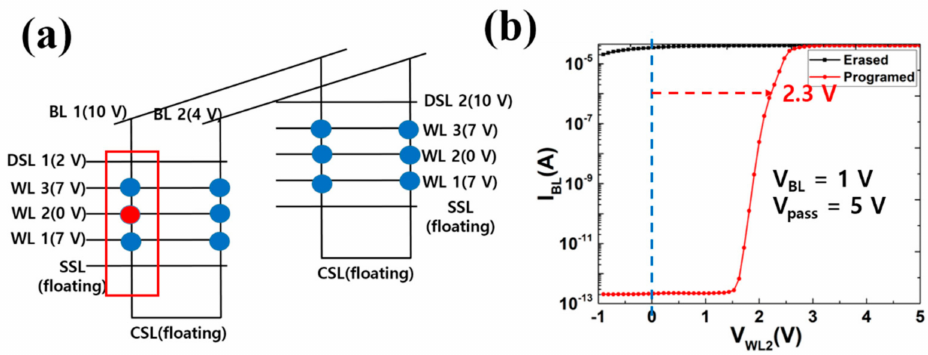
Figure 6. Memory simulation results for program operation: ( a ) program operation voltage and ( b ) operation results.